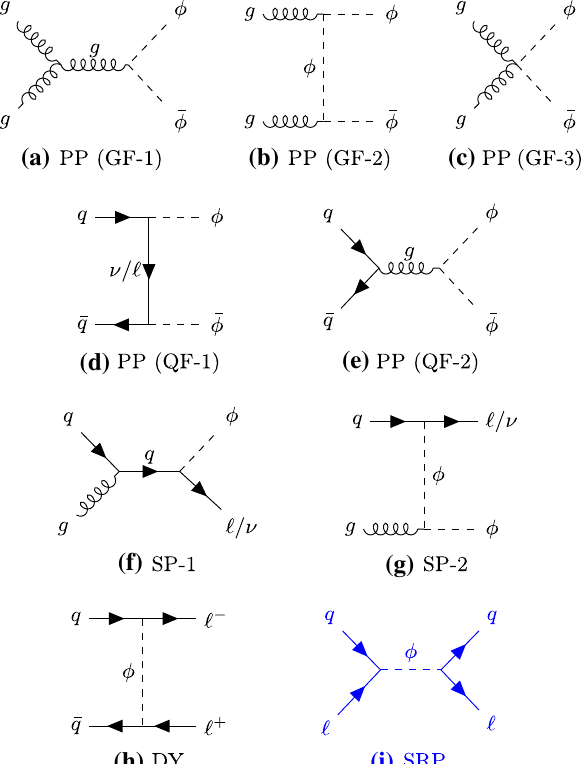
Fig. 18 Leading-order Feynman diagrams involving direct bounds on leptoquarks. The first two rows correspond to Leptoquark pair produc- tion (PP) at LHC, while the third and fourth rows signify single produc- tion (SP) of leptoquark associated with a quark, leptoquark contribution to Drell–Yan-like di-lepton process and single resonant production of leptoquark (SRP). Regarding pair production, the first three diagrams indicate gluon fusion (GF), while the last two illustrate quark fusion (QF). The photon and Z-mediated diagrams have been ignored due to the very small